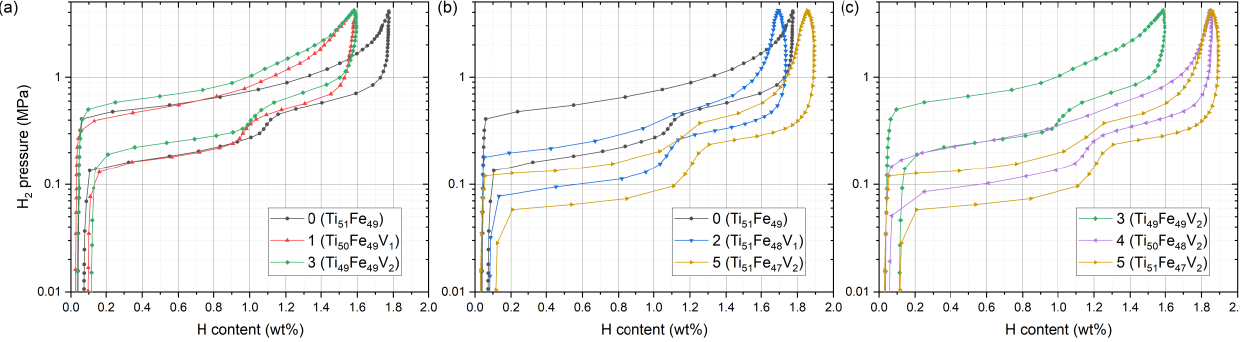
Figure 7. PCI curves for the three series of the samples measured at 30 ◦ C: ( a ) 0, 1, and 3; ( b ) 0, 2, and 5; ( c ) 3, 4, and